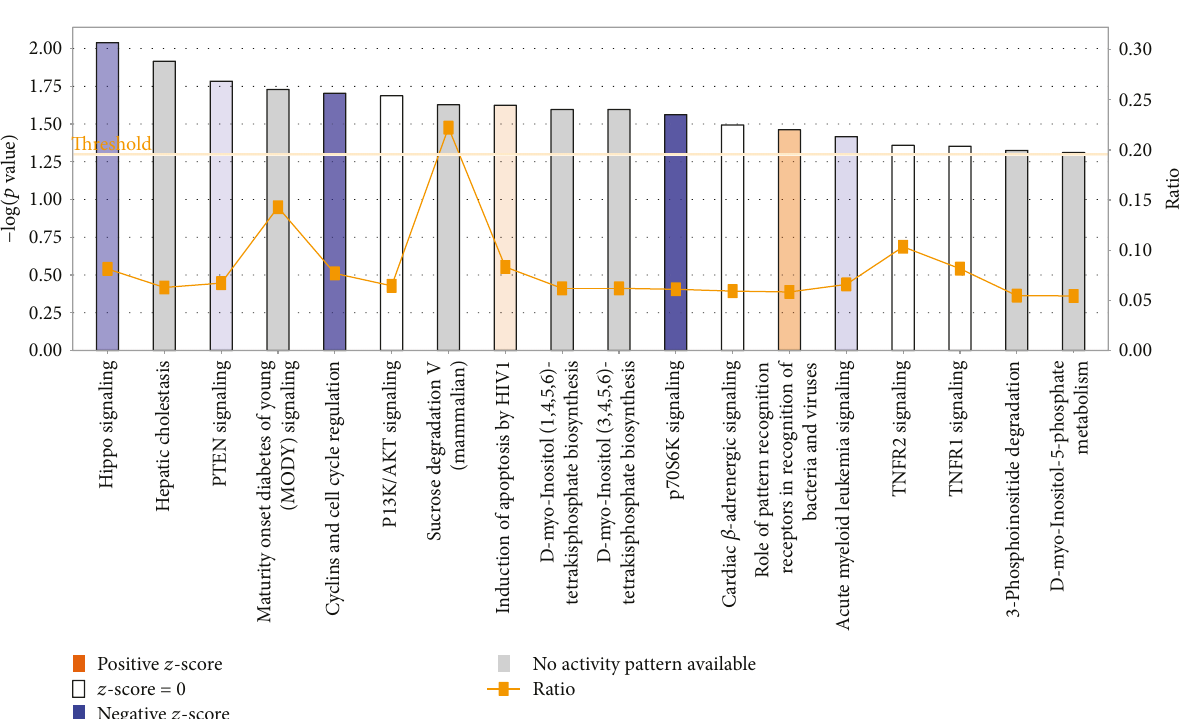
Figure 3: Top canonical pathways altered by citalopram. This bar graph enlists the top canonical pathways predicted to be altered by citalopram treatment using ingenuity pathway core analysis. Citalopram treatment results in di ff erential methylation of signi fi cant genes from our dataset that are enriched in canonical pathways, like Hippo signaling, PTEN signaling, maturity-onset diabetes of the young (MODY) signaling, and cyclins and cell cycle regulation signaling based on their z -score, ratio, and − log ( p value). A positive z -score (orange) denotes activation of pathway (e.g., role of pattern recognition receptors in recognition of bacteria and viruses), and a negative z - score (blue) denotes inhibition of a pathway (e.g., P70S6K signaling). The ratio (orange line with blocks) represents a ratio of genes from our dataset that is enriched in the pathway divided by the total number of genes enriched in the same pathway according to current IPA database [e.g., 22.5% sucrose degradation V (mammalian)]. Threshold is set at the lowest level of con fi dence that is acceptable statistically ( p < 0 05